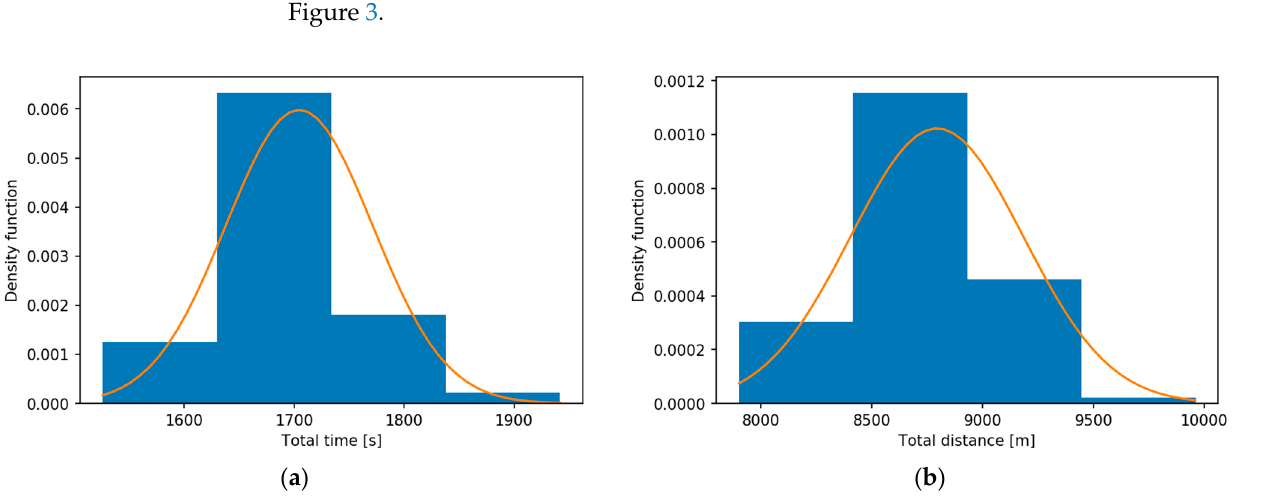
( b ) Figure 4. Histograms for 3D feasible MTSP routes according to time ( a ) and distance ( b ). Mean total time for all 3D feasible solutions was 1652 s, with population standard deviation of 88 s and spread between maximum and minimum time was 305 s. Mean dis- tance for all those routes was 8376 m with population standard deviation of 392 m and spread between maximum and minimum distances was 1416 m. All given values were rounded to a full second or meter accordingly. Best found route, according to total travel time using MTSP-First algorithm was [[0, 5, 3, 9, 0], [0, 6, 8, 0], [0, 10, 7, 2, 0], [0, 1, 4, 0]] with total time of 1526 s and total distance of 7913 m. This route is shown on Figure 5.